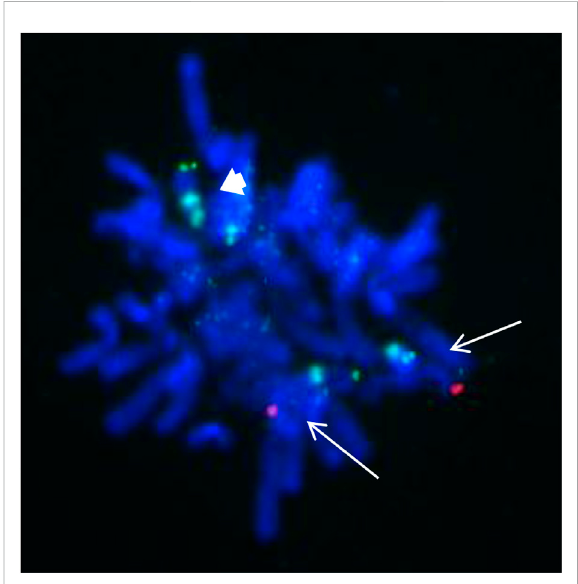
FIGURE 4 FISH from the uncultured amniocytes. Green signals indicate the subtelomeric part of chromosome 9p; red signals indicate the subtelomeric part of chromosome 9q; aqua signals indicate the centromeic of chromosome 9. Two normal chromosome 9 contain both green and red signals as showed with white arrow. The isodicentric chromosome 9p (bold white arrow) with two green signals and two aqua